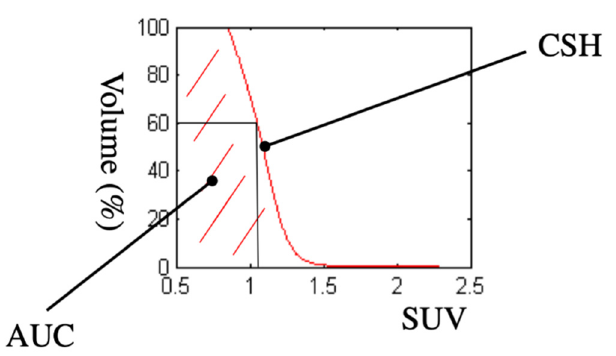
Figure 1. An example of Cumulative standardized uptake value (SUV) Histogram (CSH) and Area Under the Curve (AUC). CSH shows the percentage of the tumor volume with a certain SUV. For example, the 60% of the tumor has a SUV > 1.